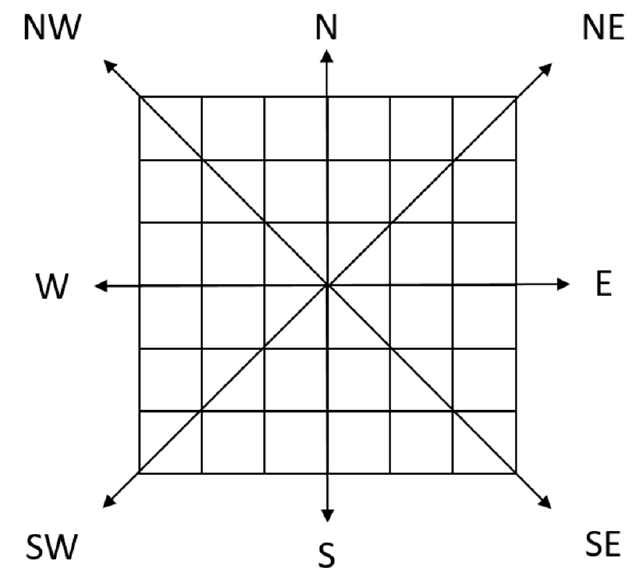
Figure 3. DEM regional division diagram.